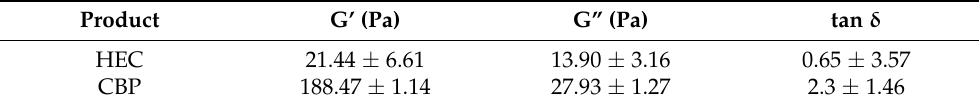
Table 3. Frequency sweep test data obtained for the formulation with hydroxyethylcellulose (HEC) and for the formulation with carbopol (CBP) at a temperature of 25 ◦ C and at a frequency value of 1 Hz. The results are presented as averages and relative standard deviations in percentage (RSD